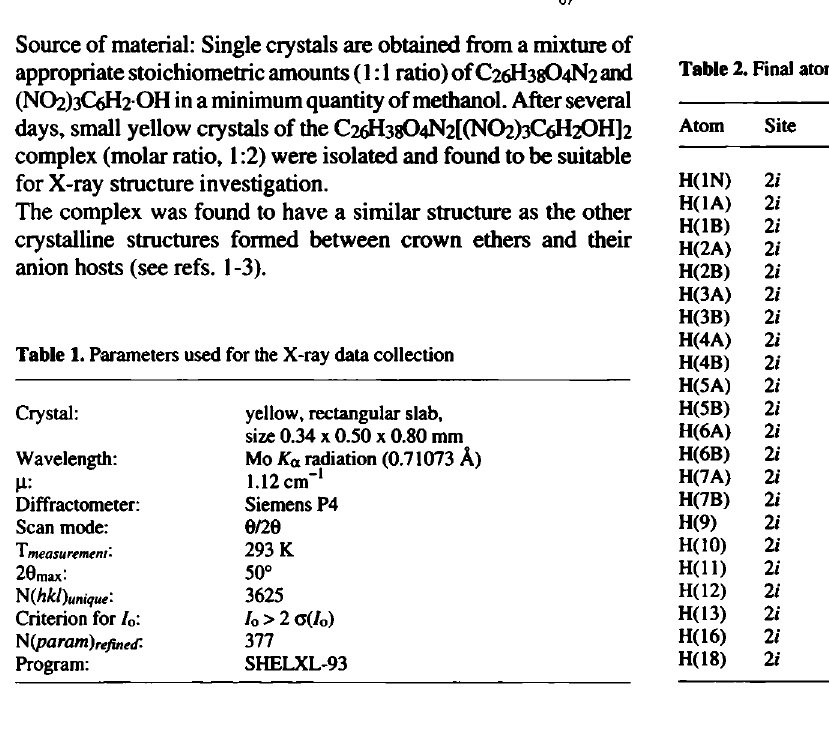
Table 2. Final atomic coordinates and displacement parameters (in Â 2